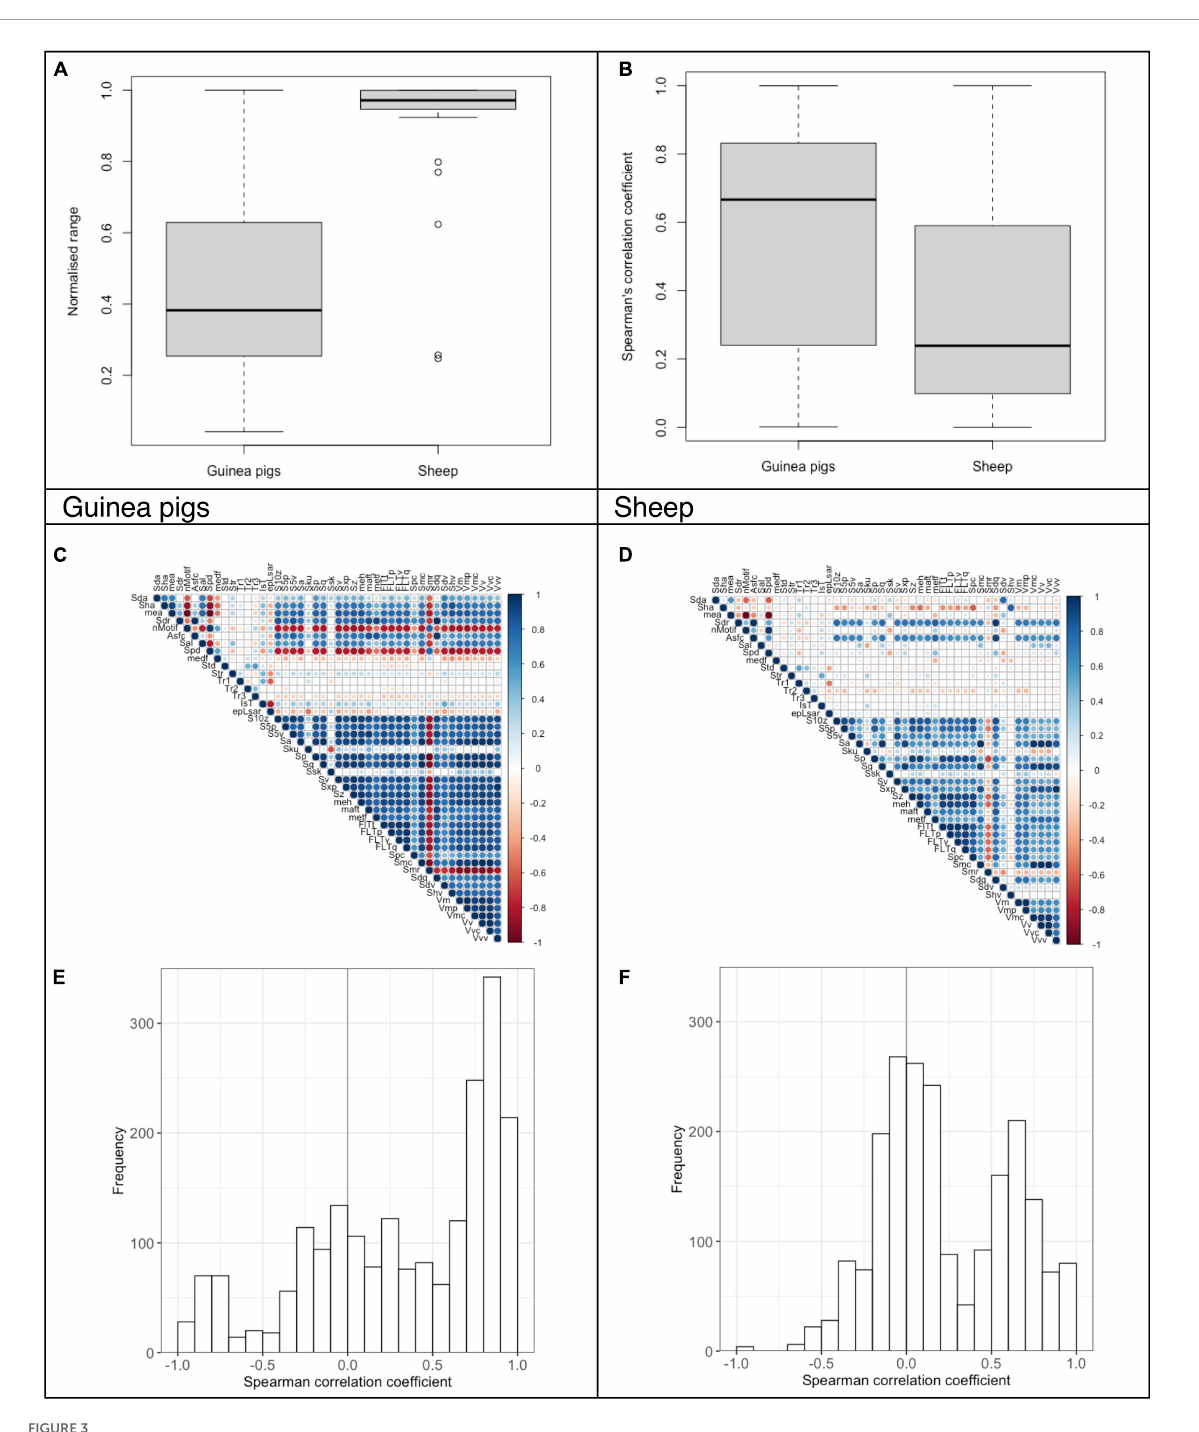
FIGURE3 Analysis of DMT parameters for guinea pigs (96 scans) and sheep (78 scans) fed a lucerne based pelleted diet with or without external quartz abrasives (diet groups: control, 4% fine silt, 4% coarse silt, 4% fine sand, 8% fine silt; dataset D). The normalized data range and the Spearman’s correlation coefficients are given as boxplots (A,B) . The Spearman’s correlation of the DMT parameters is also shown as a correlation matrix (C,D) and a histogram (E,F)